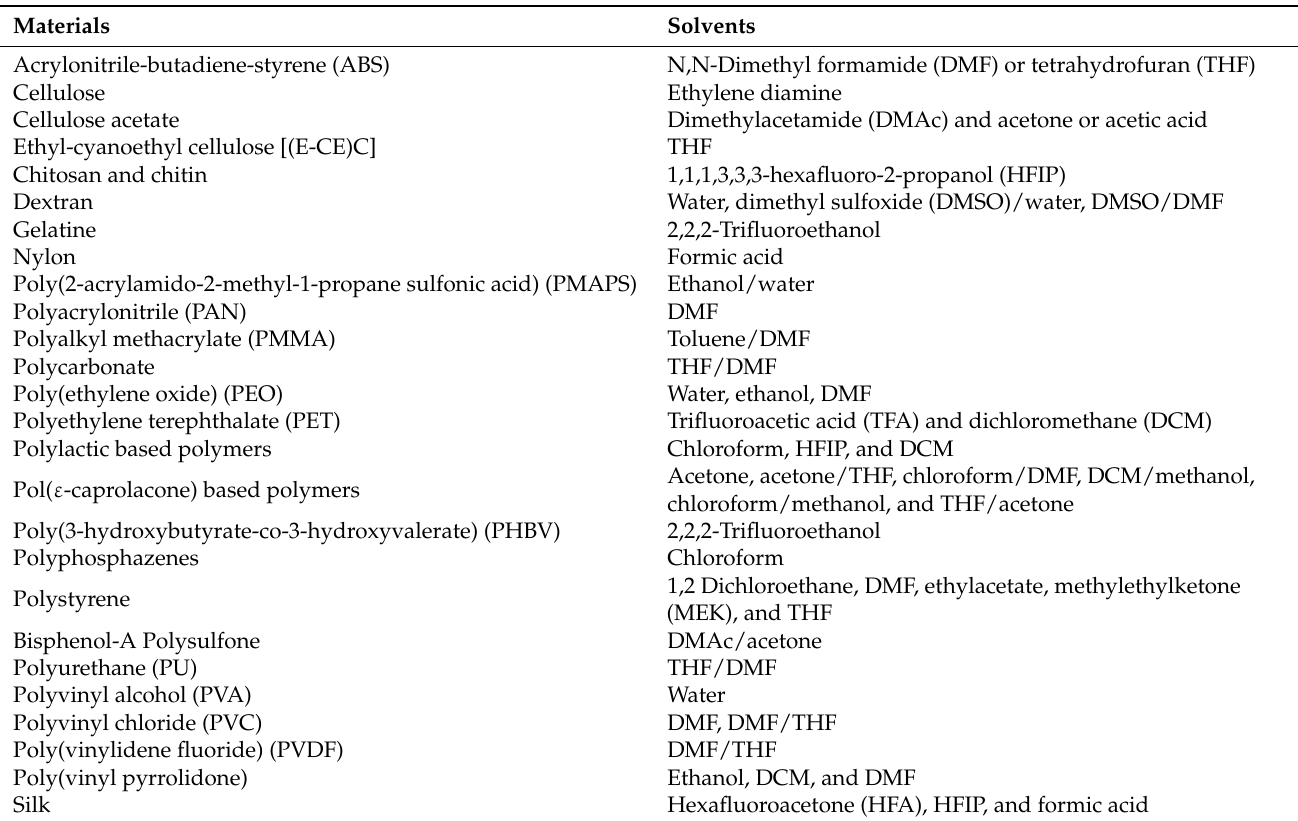
Table 1. Examples of electrospun (bio)polymer materials and the used solvents (in alphabetical order). Reprinted and adapted with permission from ref. [55]; Copyright 2015, Elsevier